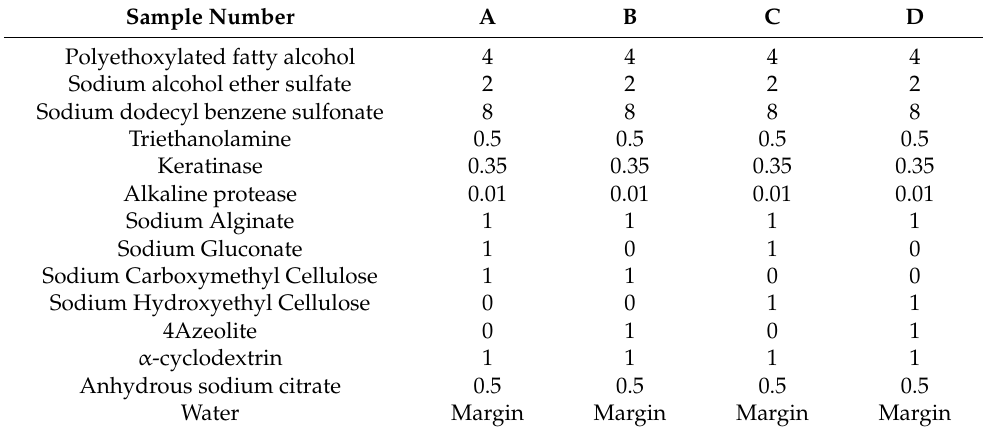
Table 6. Protease liquid detergent sample composition and ratio